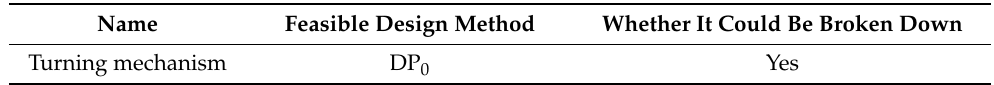
Table 3. List of FR 1 , FR 2 , and FR 3 .